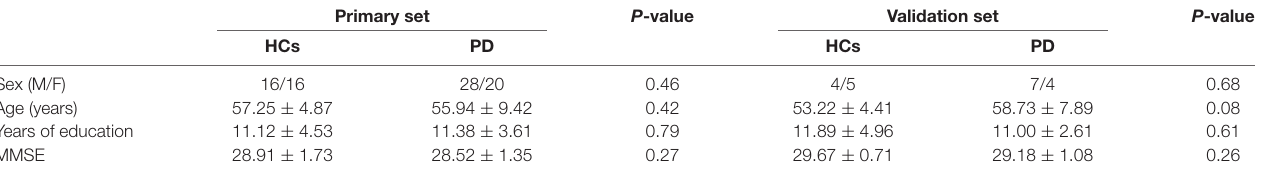
TABLE 1 | Comparison of the general clinical data between healthy controls (HCs) and Parkinson’s disease (PD) patients in the primary and validation sets. Primary set P -value Validation